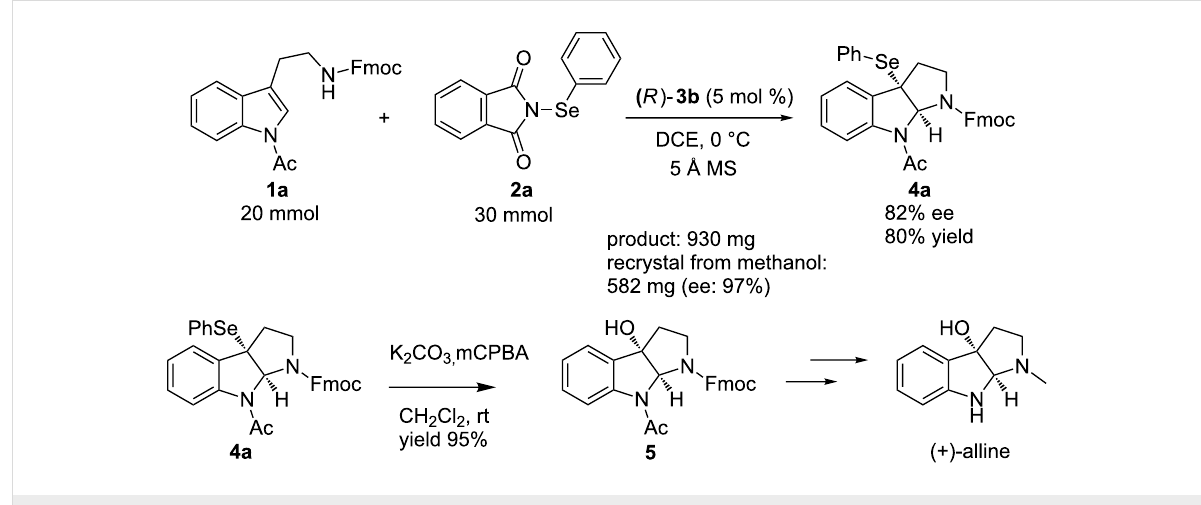
Scheme 2: Scale up of the protocol and synthetic